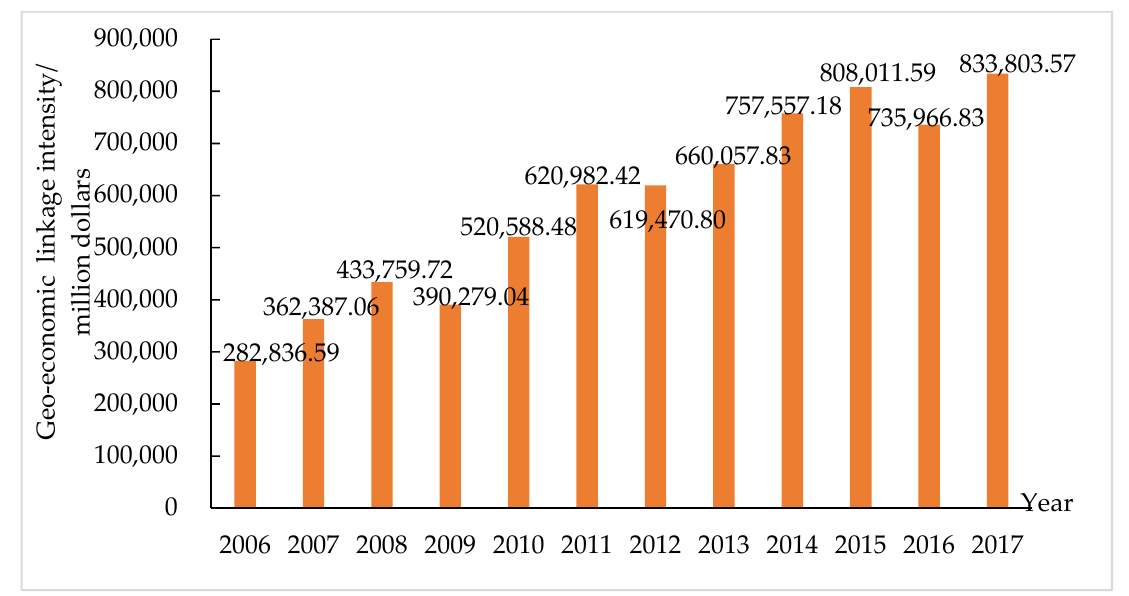
Figure 2. The variation of geo-economic linkage intensity between China and the MSRCs.